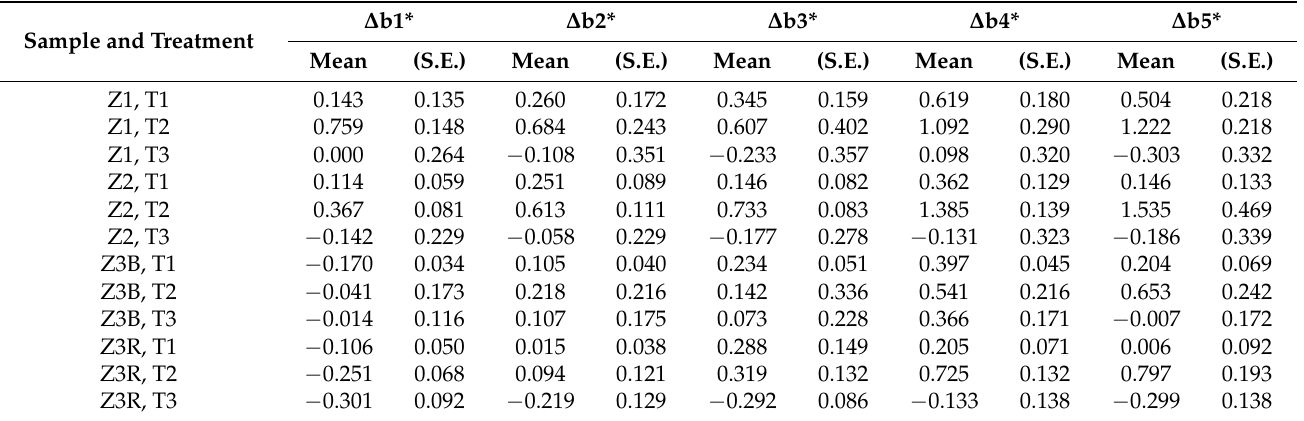
Table 5. Average values for ∆ b* for every ageing treatment